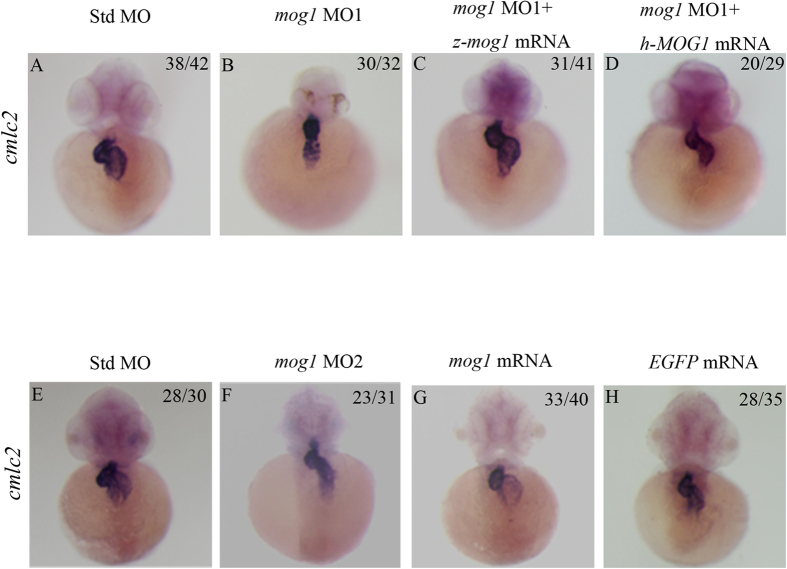
Mog1 regulates cardiac morphogenesis and development during zebrafish embryogenesis.(A,B) Whole-mount in situ hybridization with embryos injected with 16 ng of control Std-MO (A) or 16 ng of mog1 MO1 (B) with a cardiac marker, cmlc2, at 48 hpf. (C,D) Whole-mount in situ hybridization with embryos injected with 16 ng of mog1 MO1 together with 200 pg of zebrafish mog1 mRNA (C) or with 200 pg of human MOG1 mRNA (D) with a cardiac marker, cmlc2, at 48 hpf. Note that overexpression of mog1 rescued the defects in mog1 morphants. The construct for making zebrafish mog1 mRNA was mutated at 5 positions (from ATG TCA CGG CCT CTG TTT to ATG TCT CGT CCG CTA TTC) so that mog1 MO1 can knock endogenous zebrafish mog1 mRNA down, but not the in vitro synthesized mog1 mRNA used for injection. The mog1 MO1 cannot bind to human MOG1 mRNA so that it cannot knock the in vitro synthesized human MOG1 mRNA down. (E,F) Whole-mount in situ hybridization with embryos injected with 16 ng of control Std-MO (E) or 16 ng of mog1 MO2 (F) with a cardiac marker, cmlc2, at 48 hpf. (G,H) Overexpression of mog1 did not cause changes of cardiac phenotype compared with embryos injected with EGFP mRNA (negative controls). The numbers in the upper right corner (e.g. 38/42 in A) describe the ratio of the number of embryos with the phenotype (e.g. 38) in the image over the number of total embryos analyzed (e.g. 42). Scale bar = 100 μM.